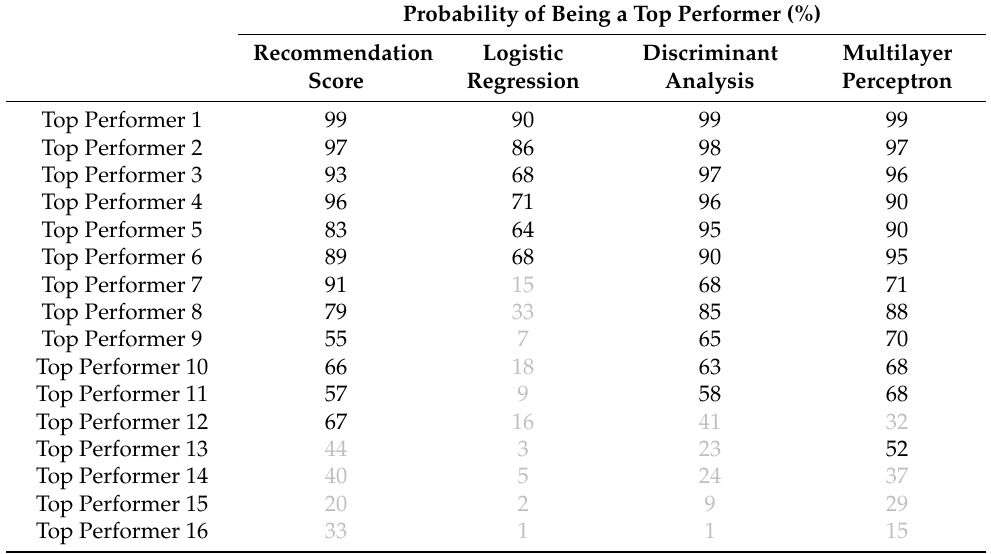
Table 8. Probability outputs of the analysis